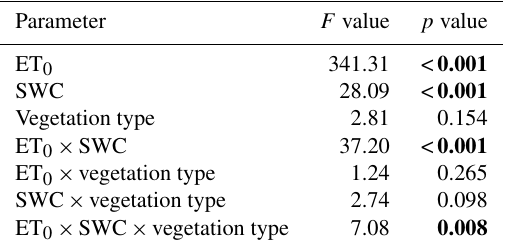
Table 2. Parameter and parameter interactions affecting the ET0- SWC landscape of ET. Significant p values are in